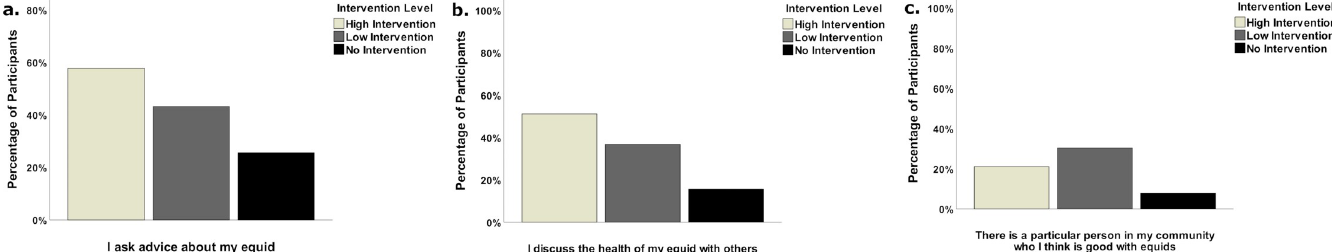
Fig 4. Bar graphs showing the percentages of participants across intervention levels who a) ask for advice about their equid, b) discuss the health of their equid with others, c) think that there is a particular individual in their community who is good with equids.